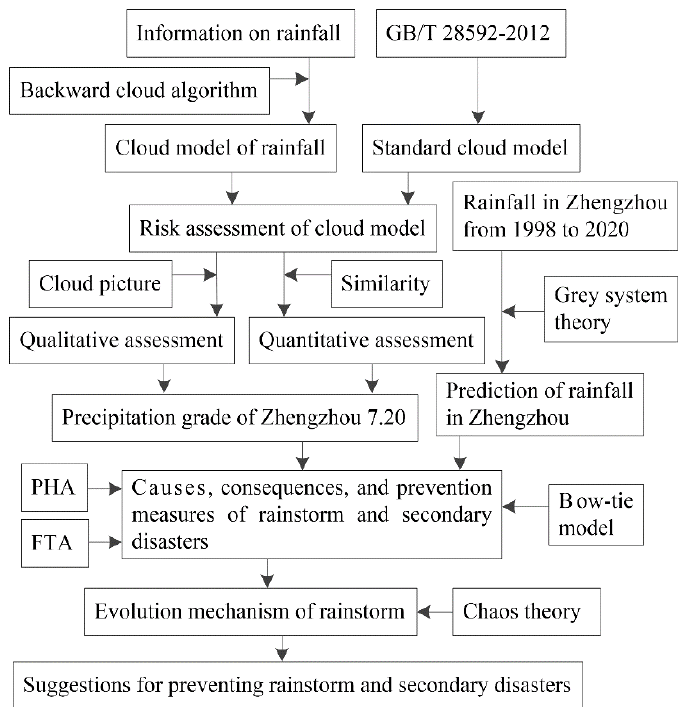
Figure 1. The framework of the risk assessment method proposed in this study.